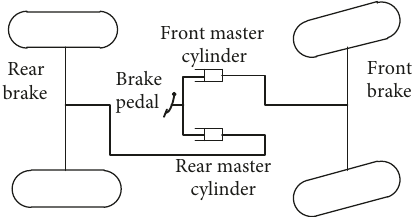
Figure 12: Dual-loop braking system in